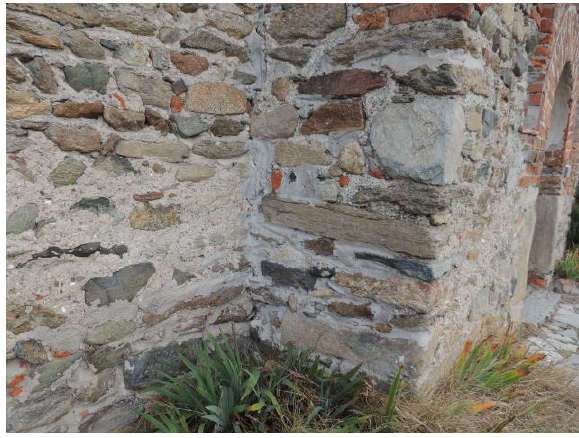
Figure 13. Building A - Grouting with cement mortar (credits Fabio Fratini).